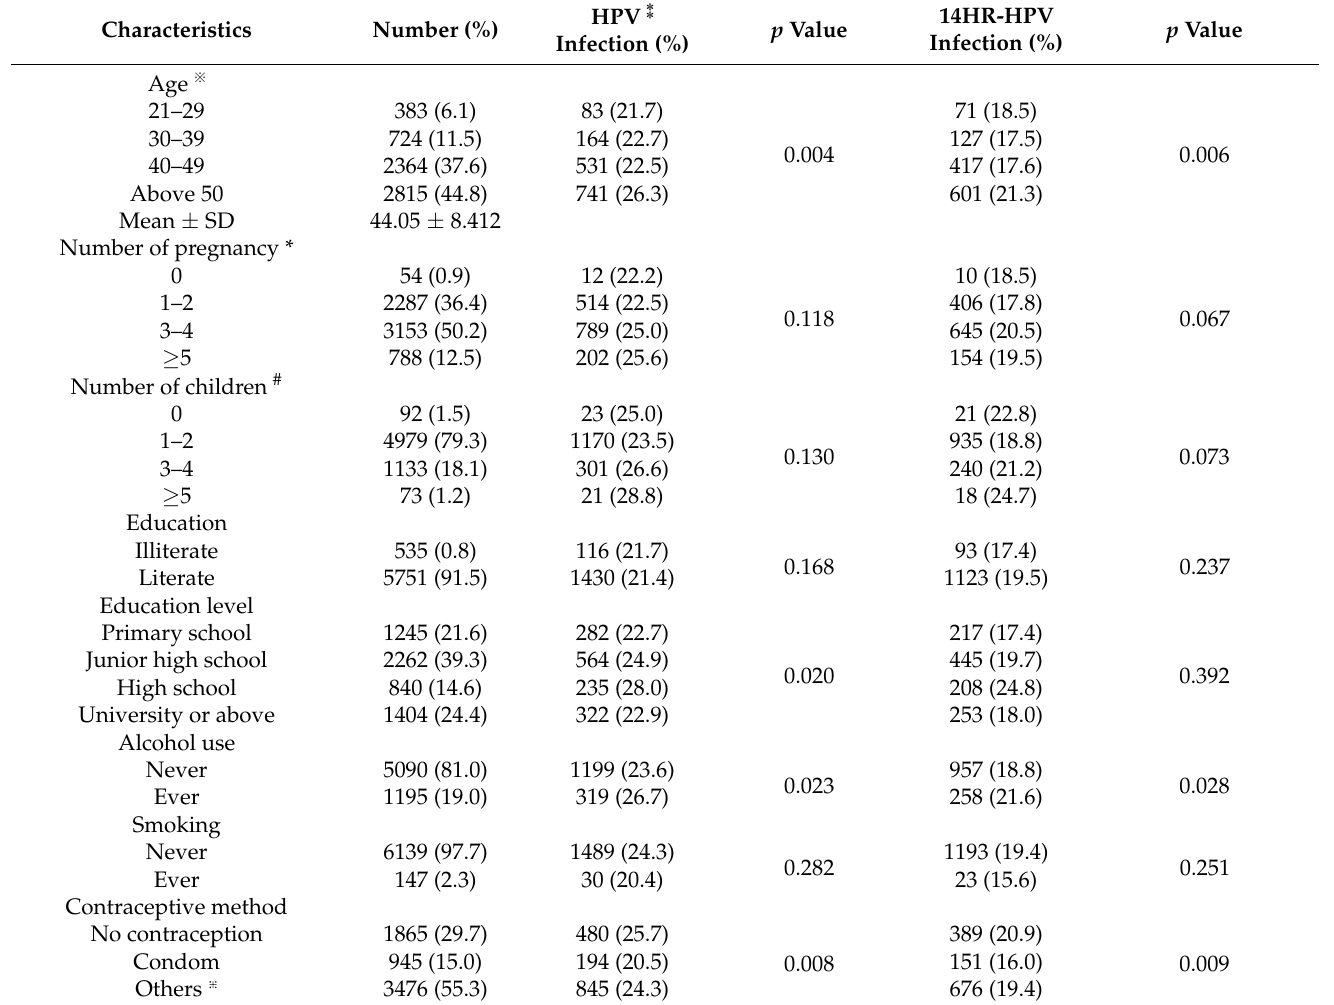
Table 1. Characteristics and distribution of HPV infection among women living in China n = 6286.